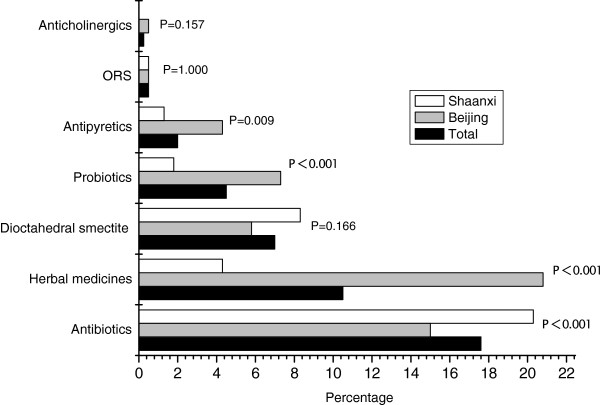
Self-medication before visiting the diarrhea clinic. p-values refer to comparisons between Beijing and Shaanxi province. ORS: oral rehydration solution.